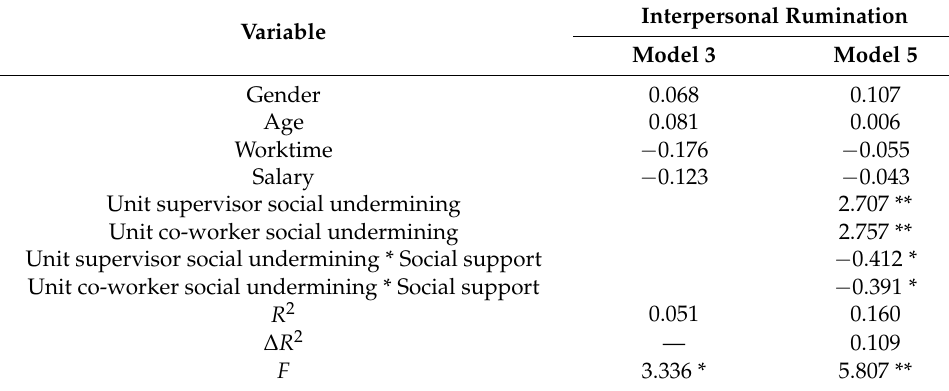
Table 7. The moderating effects of unit social support.